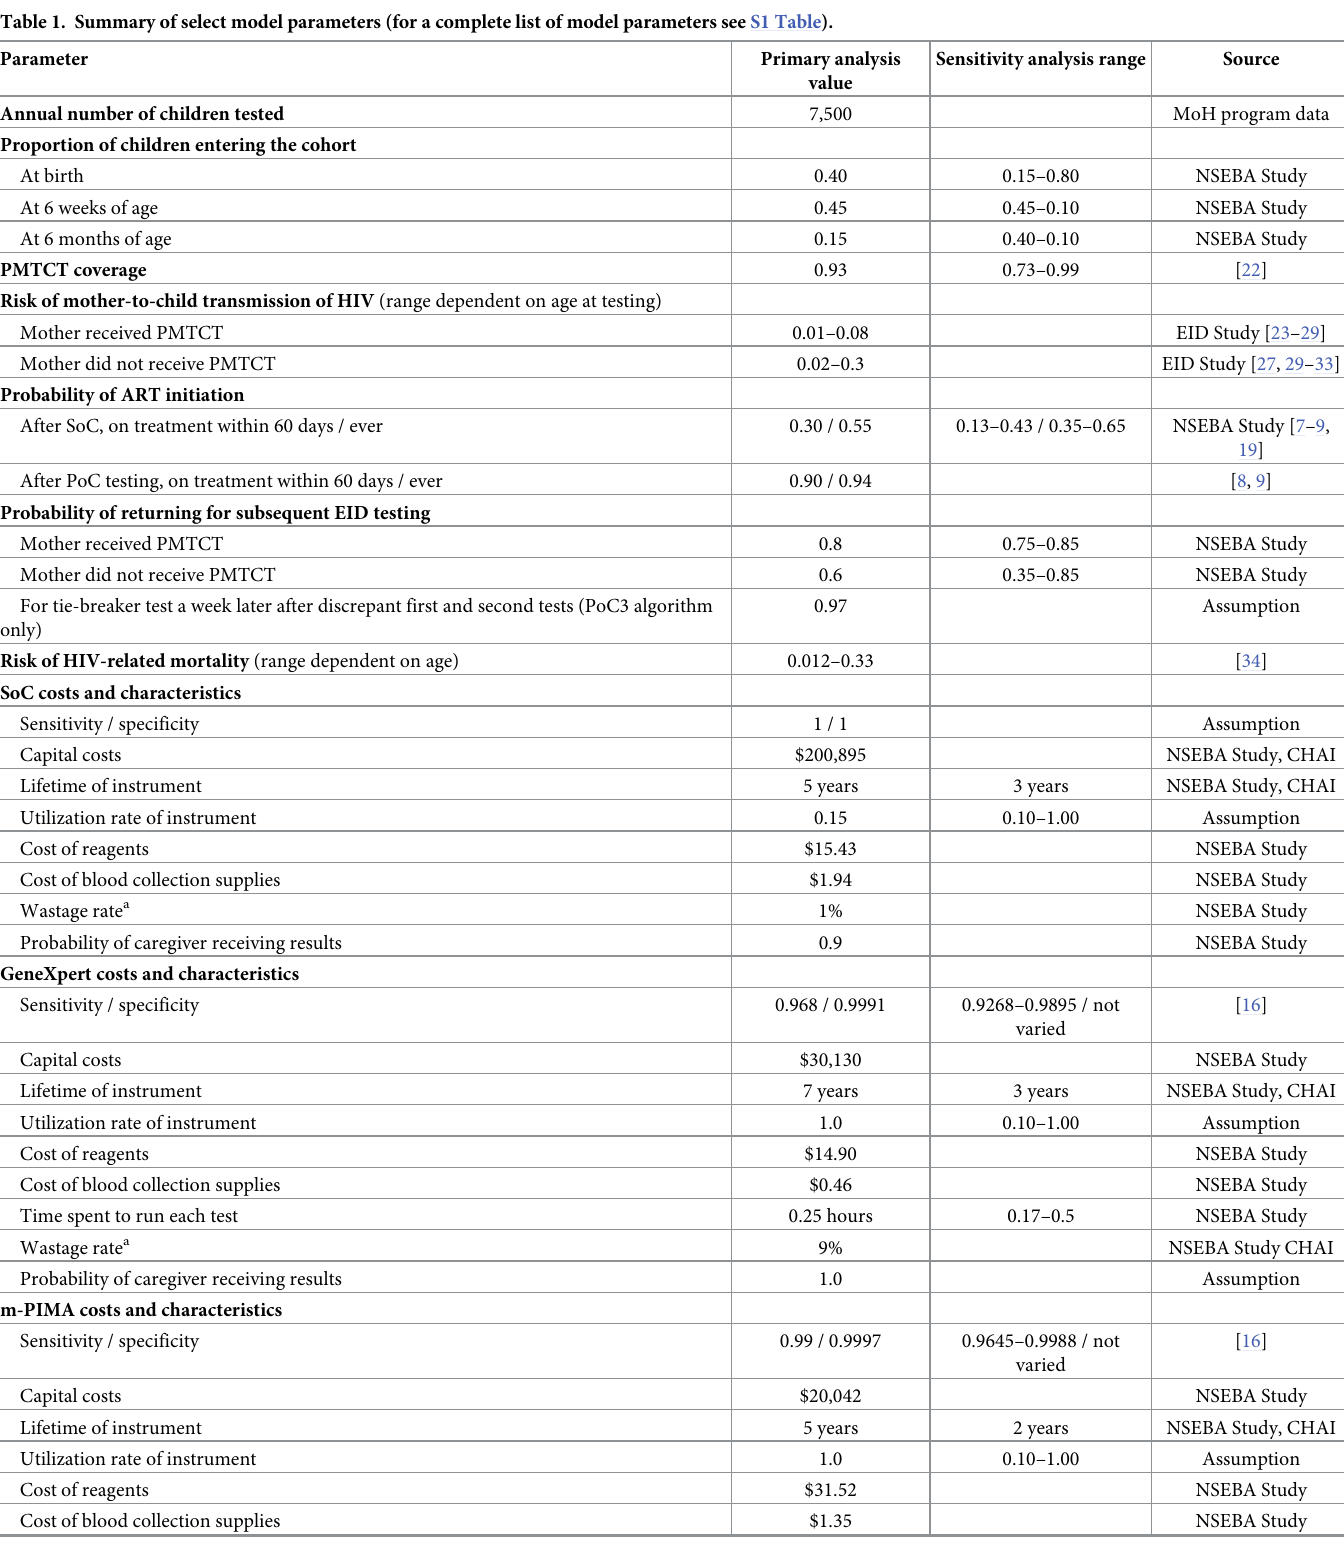
Table 1. Summary of select model parameters (for a complete list of model parameters see S1